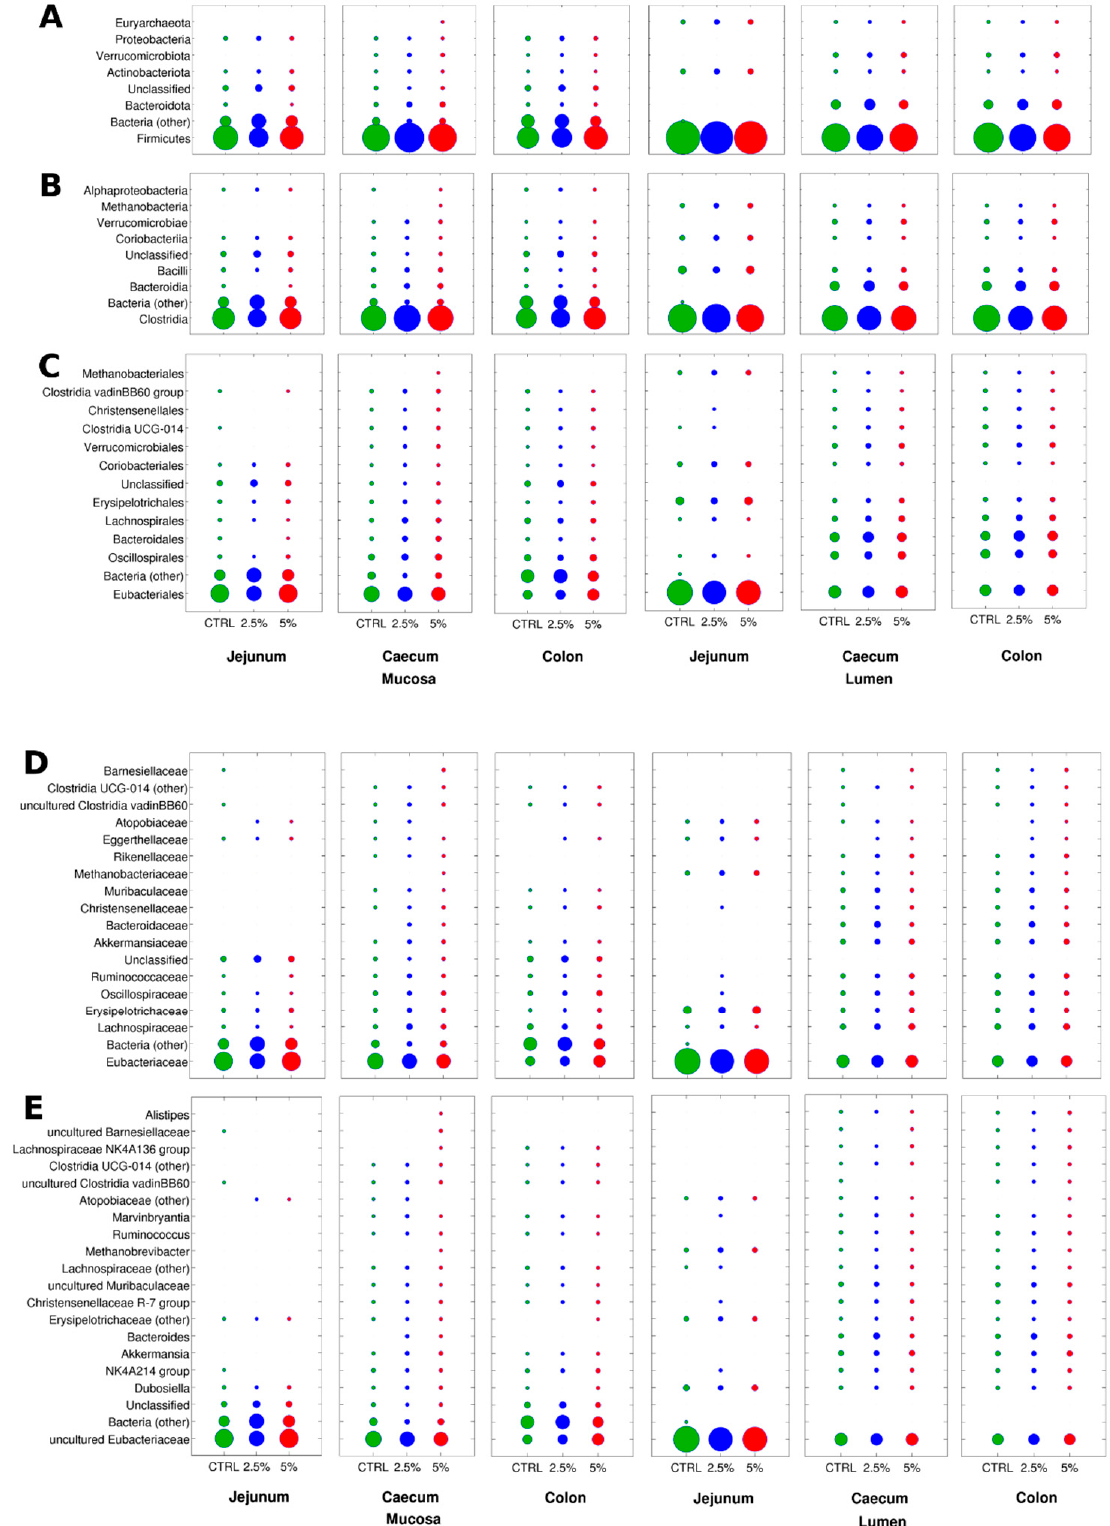
Figure 4. Bubble plots of the relative abundance data (for each intestinal tract and site) over the three groups at all taxonomic levels: CTRL (green), 2.5% BC (blue), and 5% BC (red); phylum ( A ), class ( B ), order ( C ), family ( D ), and genus ( E ). Circle size is proportional to the average relative abundance. For each level, only taxa with avg. rel. ab > 1% in at least one of the groups are represented. “Missing” circles are taxa < 1% in that group.